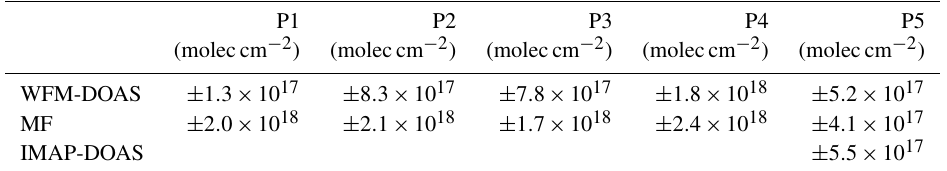
Table 5. Comparison of background noise of the retrievals based on the standard deviation of retrieval results near the plumes. As we only have IMAP-DOAS results for one plume, the other fields are left empty.